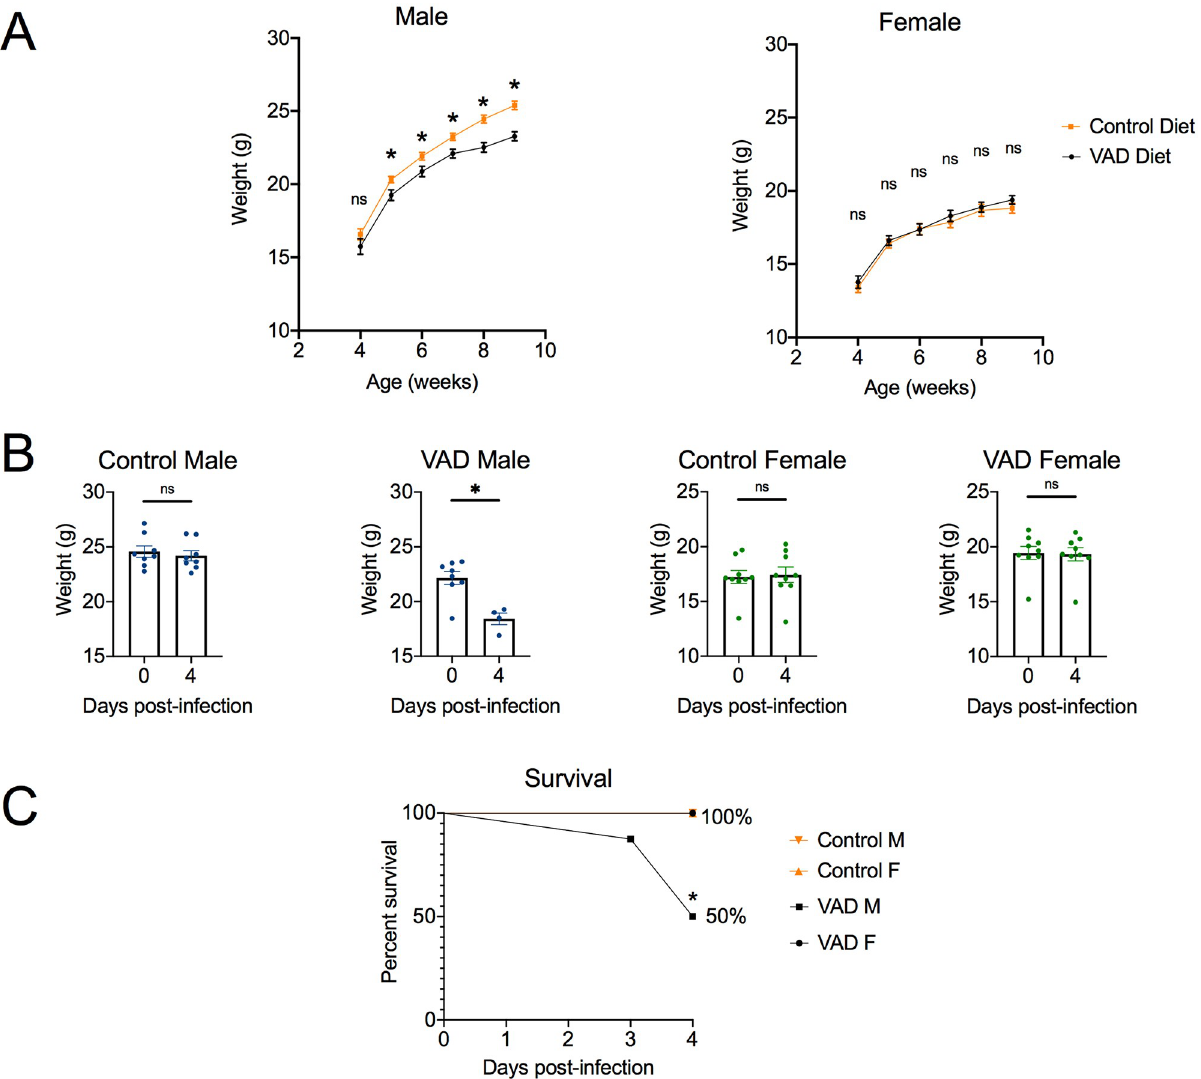
Fig 2. Increased weight loss and decreased survival seen in VAD male mice infected with Salmonella . Weight (g) of VAD and control male and female mice was recorded weekly ( A ) during growth from 4 weeks to 9 weeks (n = 26–30). Nine week-old mice were infected with S . Typhimurium D23580 via the intraperitoneal (i.p.) route and weight (g) was monitored daily ( B ) for up to 4 days post-infection (n = 8–9). Data are represented as mean ± SEM. Significance between weights by diet or day was determined using a Mann-Whitney test ( � , p < 0.05; ns, not significant). ( C ) Percent survival was assessed for all groups over the 4-day infection with a Kaplan-Meier survival curve (n = 8–9). Results are reported as percent survival. Pairwise comparisons between the VAD male group and each other group was determined with a survival analysis log-rank (Mantel-Cox) test ( � , p < 0.05). All data represent a compilation of data from three independent